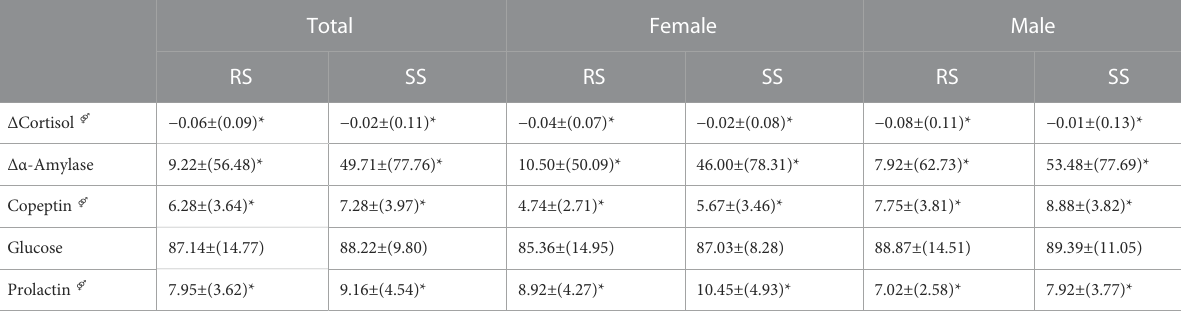
TABLE 4 Biochemical variable